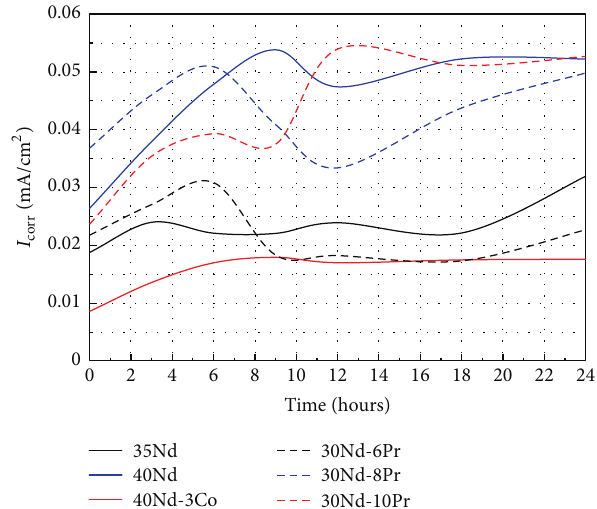
Figure 18: 𝐼 corr variation against time for the tested magnets. Determined from 𝑅 ct values of EIS measurements.